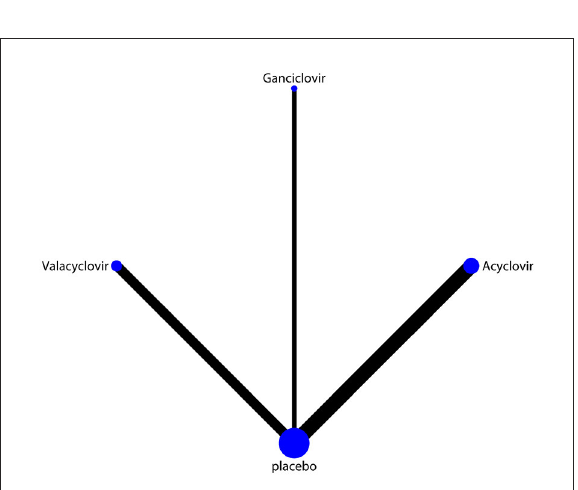
FIGURE2 Network of comparisons for hearing recovery included in the analysis. The nodes were weighted by the number of trials, and the edges were weighted by the precision of the direct estimate for each pairwise